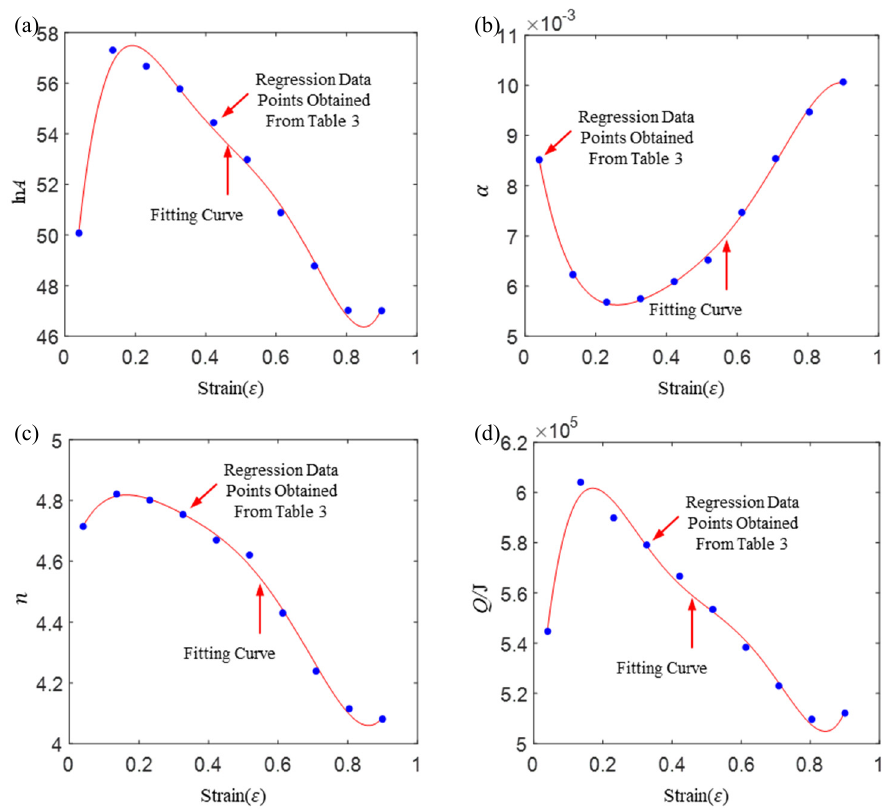
Figure 3. Nonlinear regression values of material parameters at different strain levels and their polynomial fitting: ( a ) lnA- ε ; ( b ) α - ε ; ( c ) n- ε ; ( d ) Q- ε .